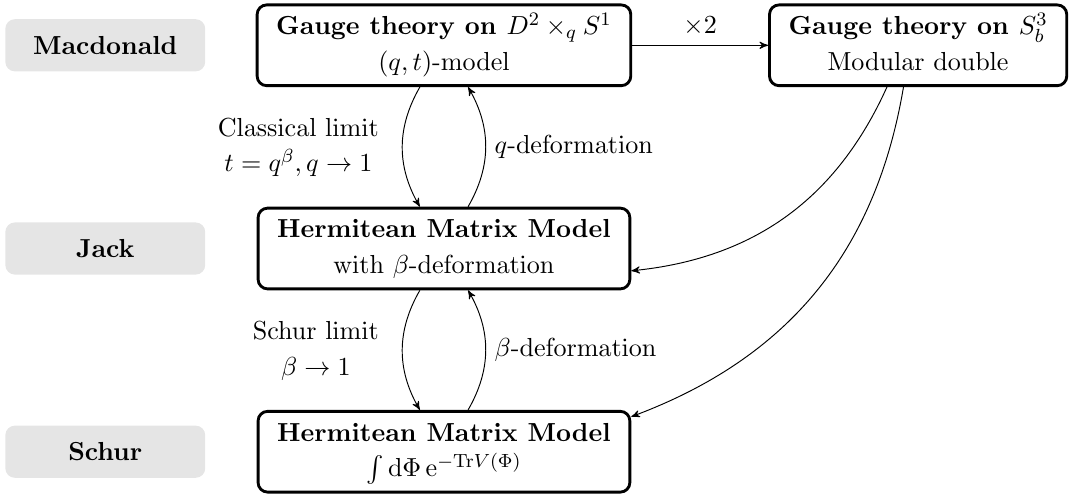
Figure 1 . Schematic relation between the matrix